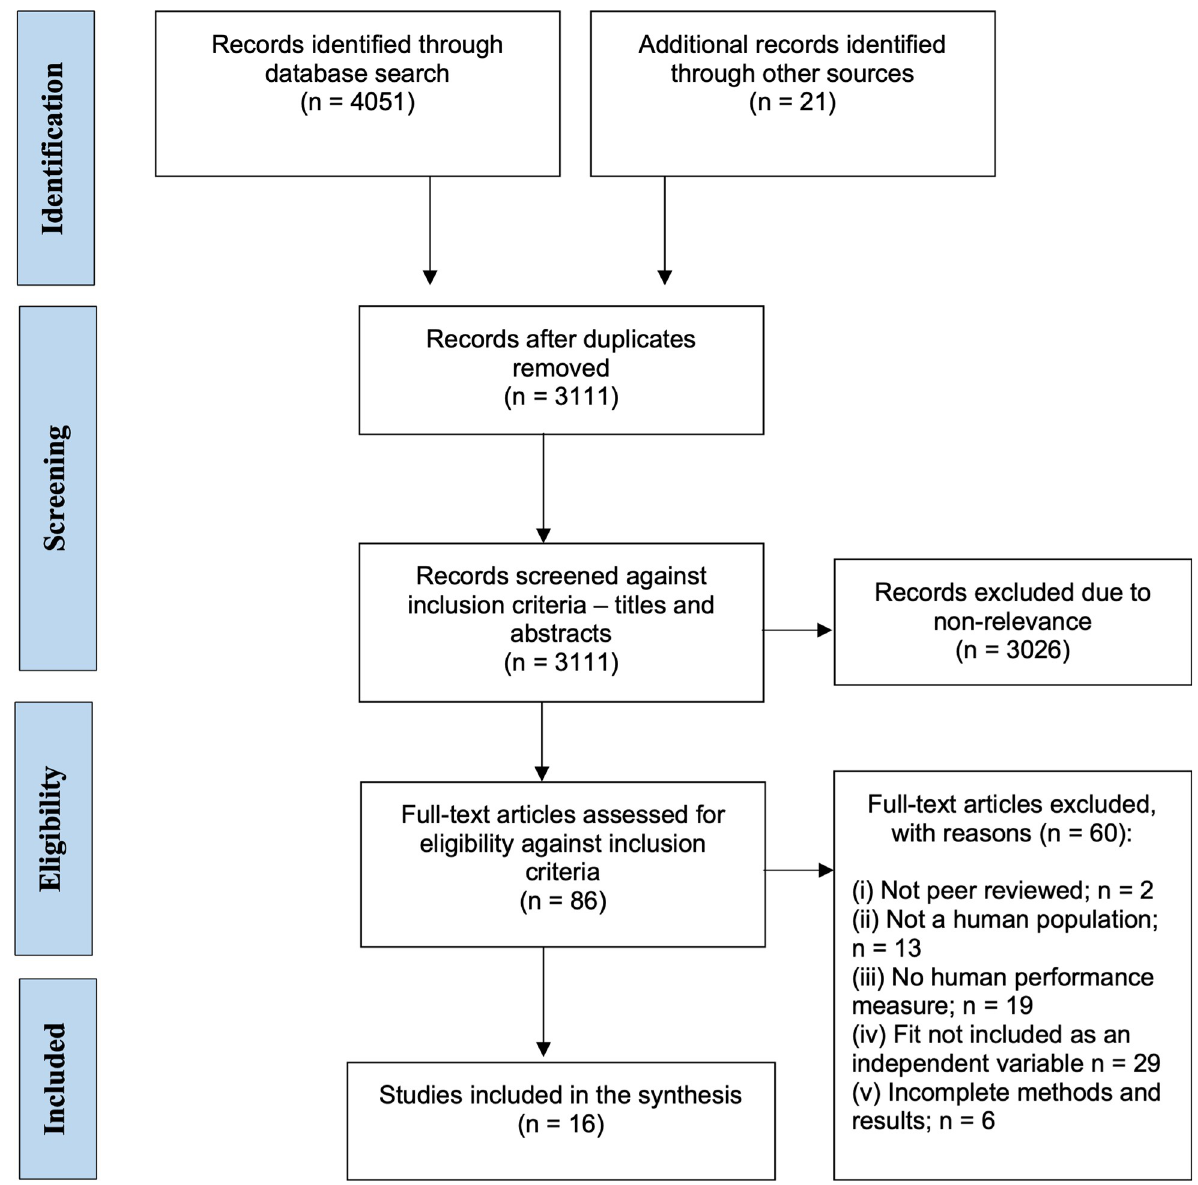
Fig 1. PRISMA flow diagram [43] of the study selection, including literature search and reasons for exclusion. The reason for exclusion of an article was based on a hierarchy; that is, where a paper failed to meet multiple inclusion criteria, it was excluded based on the first appropriate reason and counted at this point in the exclusions